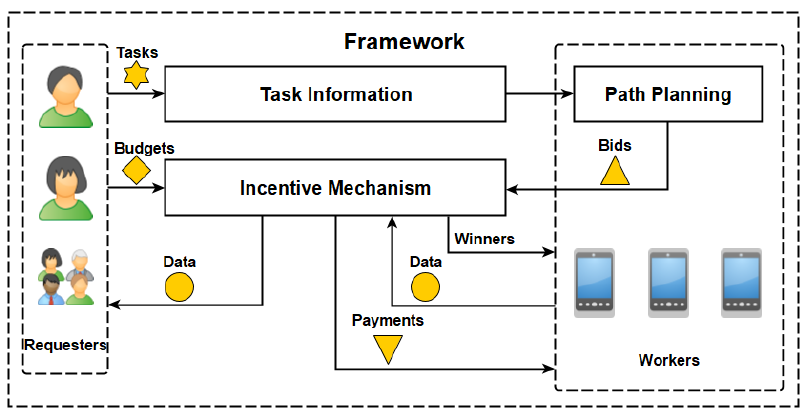
Figure 1. The proposed technical framework for mobile